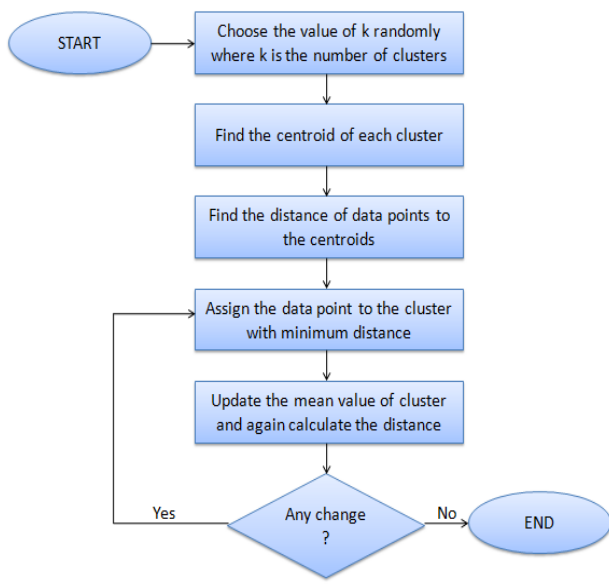
Fig. 4. Fuzzy k -means algorithm.